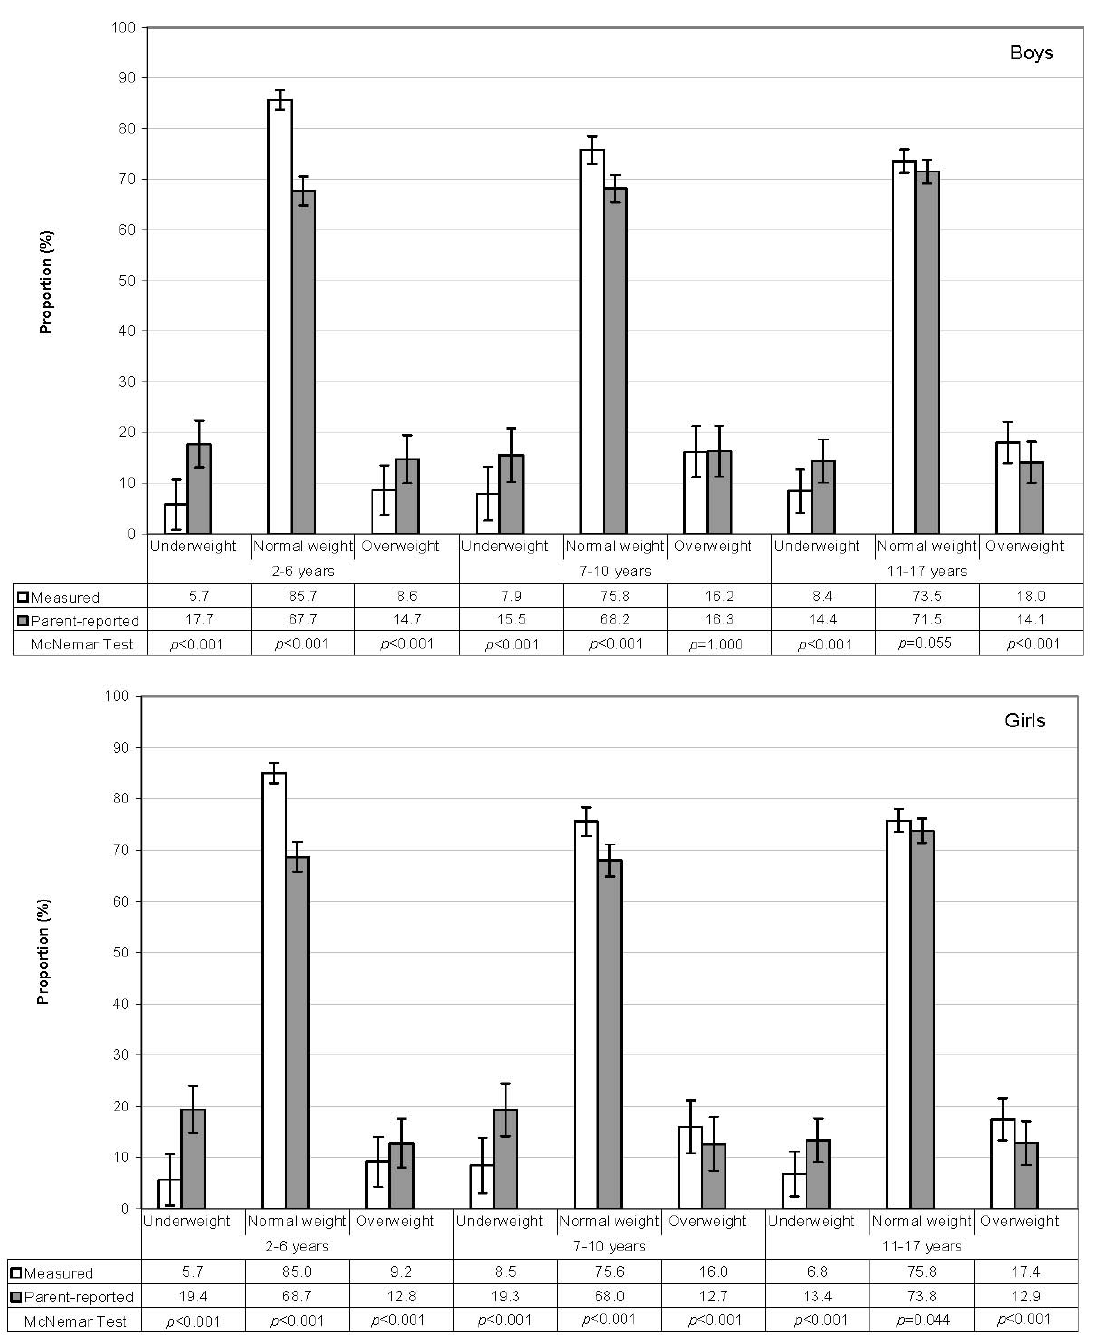
Figure 1. Proportions of underweight, normal weight and overweight by age groups for boys and